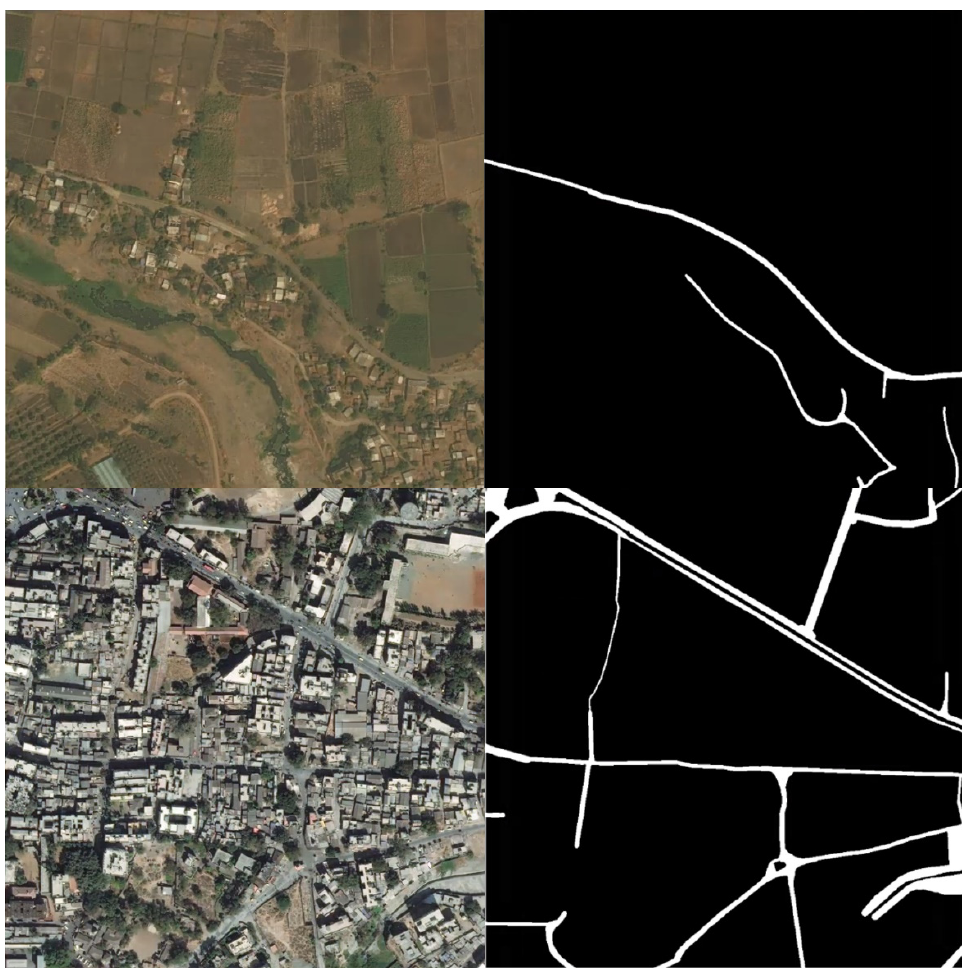
Figure 1. The example images and their labels.